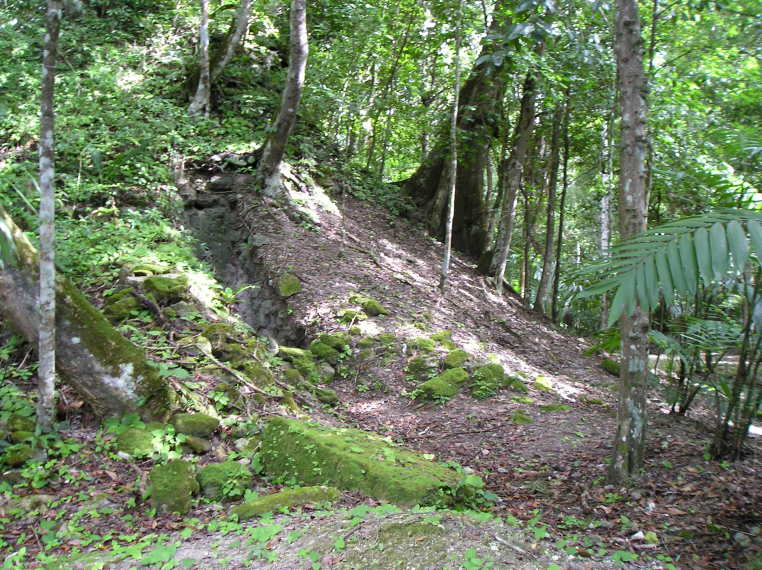
Brachypelma
sabulosum habitat, tropical moist forest, north of of Tikal, Petén department, Guatemala. Photo: Stuart J. Longhorn.